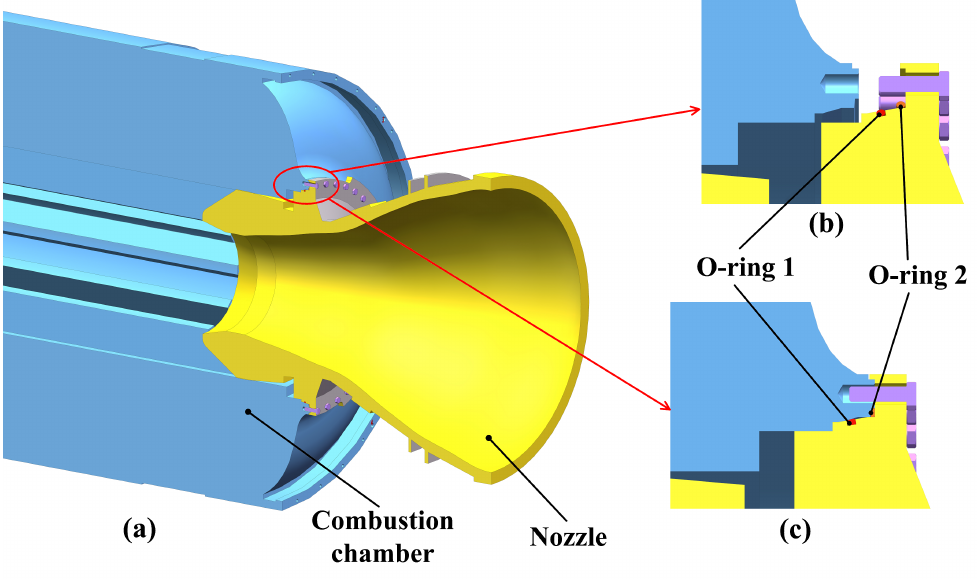
Figure 1. Structure of the SRM: ( a ) Section view; ( b ) Before assembly; ( c ) After